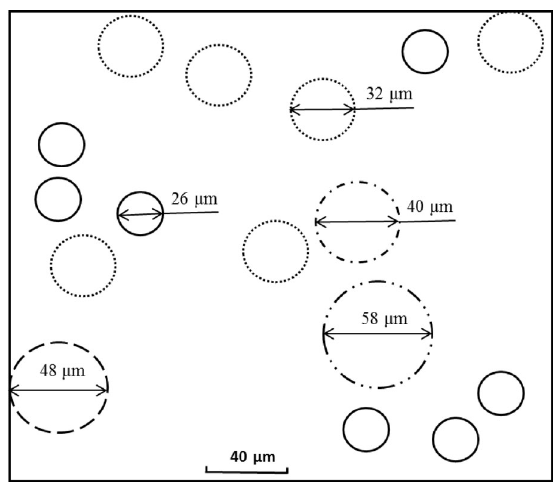
Fig. 15 Simplified patterns of PI surface texture under water after experiment.